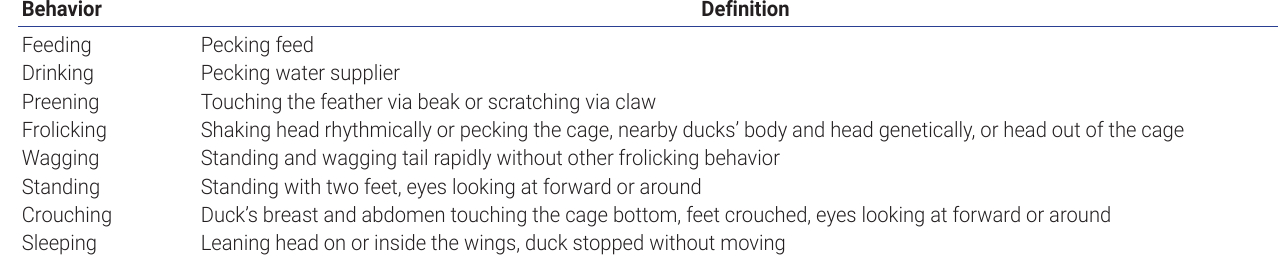
Table 2. The definition of cage rearing Brown Tsaiya ducks behaviors Behavior